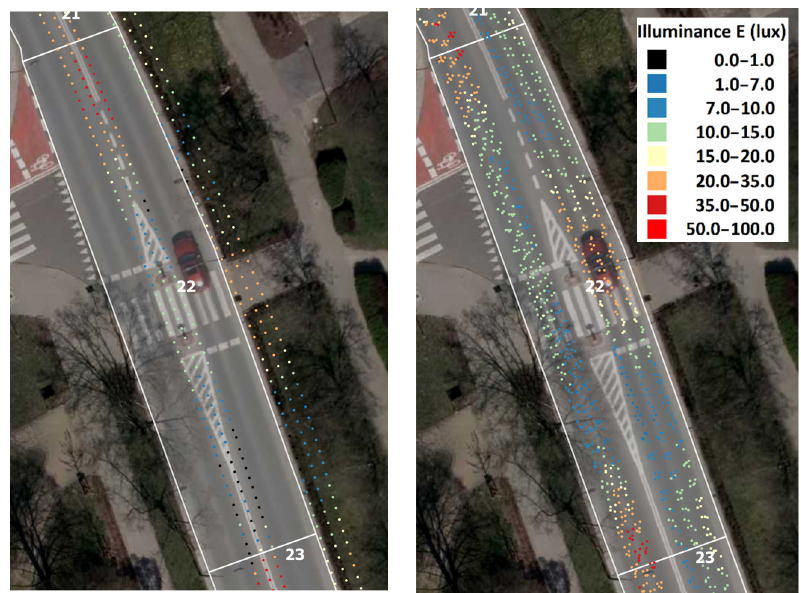
Figure 14. Comparison of the location of the illumination measurement points in field 22 using GNSS (left figure) and the five measurements with GPS RTK (right figure).